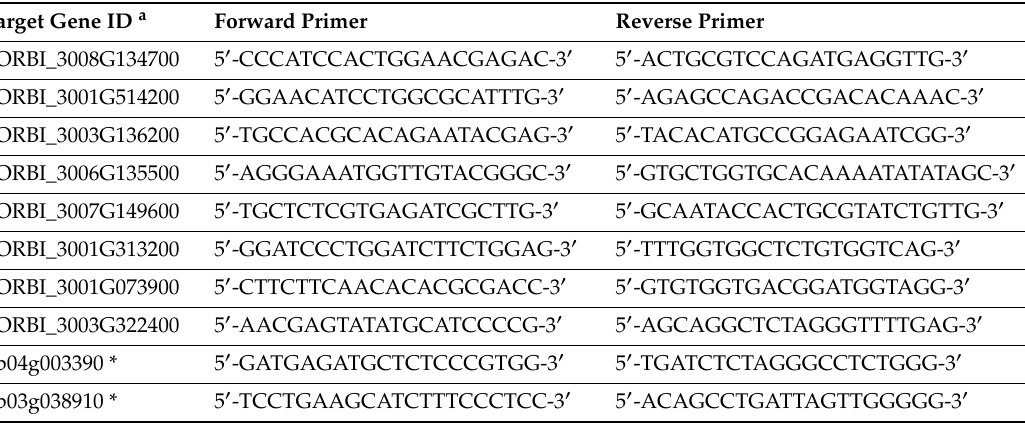
Table 1. List of primer sequences of sorghum genes used in quantitative real-time polymerase chain reaction (qRT-PCR) analysis.